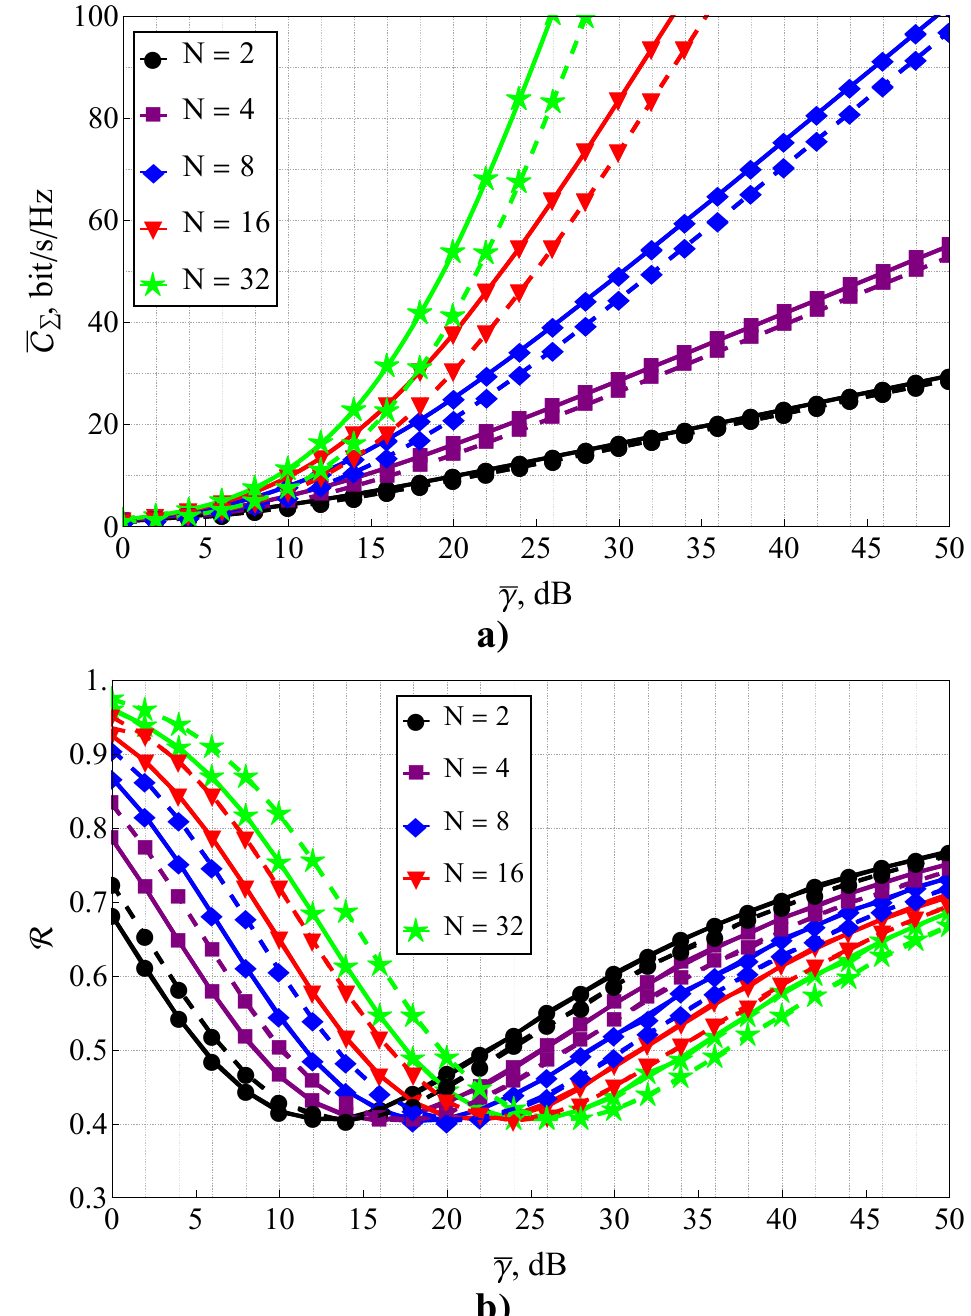
Figure 3. C Σ (subfigure ( a )) and R (subfigure ( b )) for variable γ and different MIMO system size N × N : solid lines depict the case of ρ = 0.1, dashed lines depict the case of ρ =